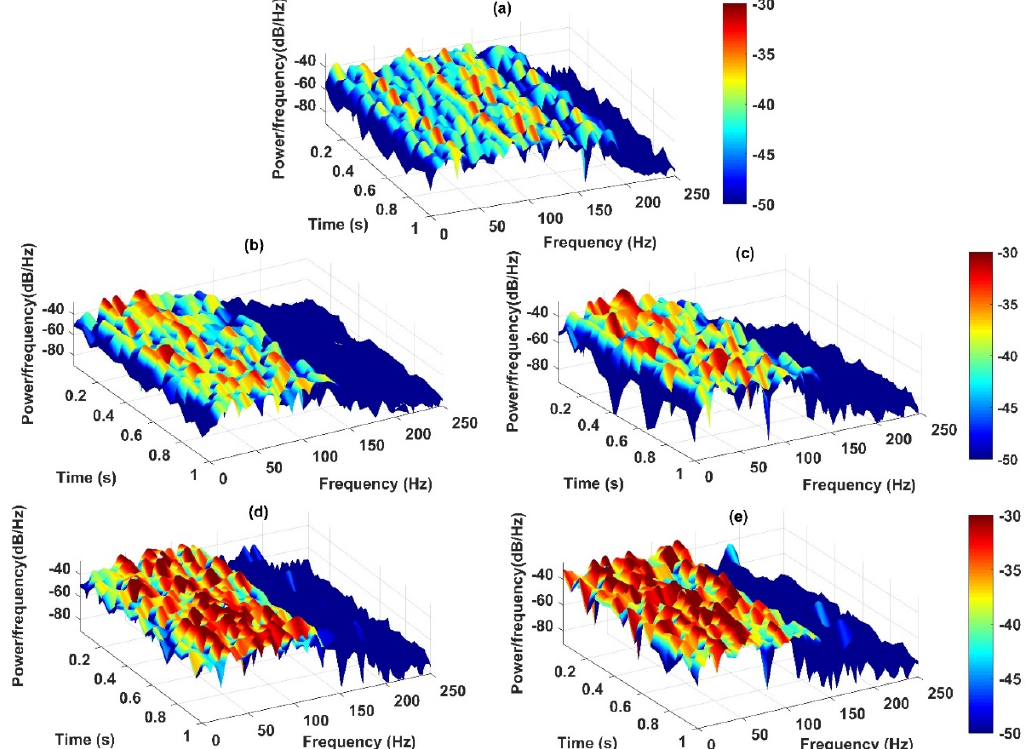
Figure 12. Spectrograms output of the IMFs of sensor-10 under five states of the structure including; ( a ) healthy; ( b ) 20% damage; ( c ) 50% damage; ( d ) 80% damage; and ( e ) 100% damage by the CEEMDAN-HT-ANN model.